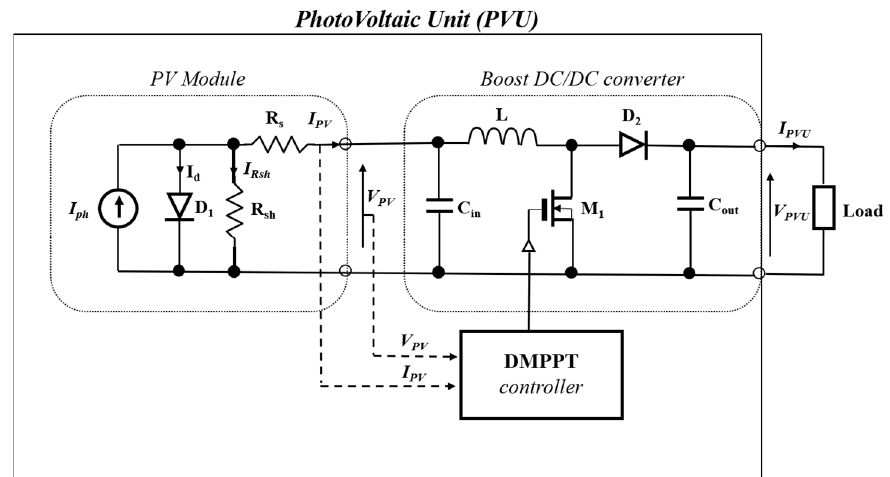
Energies 2020 , 13 , x FOR PEER REVIEW Figure 5. Circuit model of Boost based PVU. Figure 5. Circuit model of Boost based PVU.